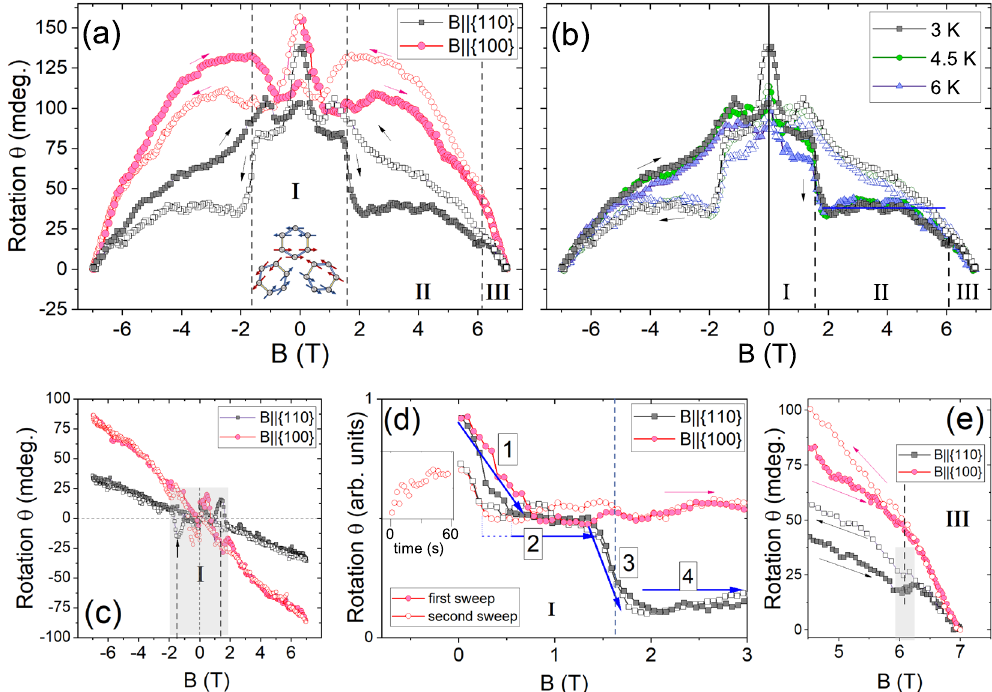
Fig. 3 Magnetic linear dichroism of α -RuCl 3 for different sample orientations. a Full magnetic fi eld sweep scans of the magneto-optical response for B ab ∥ {1, 1, 0} and B ab ∥ {1, 0, 0} at 3 K. The hysteresis loops can be divided into three fi eld regimes I, II, and III, which are discussed in the main text. b Temperature dependence of the MLD response as the magnetic fi eld is aligned along the {1, 1, 0} direction. Labels are discussed in the main text. c Linear MO response extracted from the MLD response for the two different fi eld orientations. The light gray area indicates fi eld-regime I. d Zoom-in into fi eld regime I and II for two subsequent fi eld sweeps, which are divided into four steps as discussed in the main text. Inset shows the zero fi eld time-dependent recovery of MO signal after the fi eld sweep. e High- fi eld regime III. The kink in the rotation for B ab ∥ {1, 1, 0} highlighted by the dashed line is connected to the transition towards the new AFM phase. The shaded area indicates the emergence of the intermediate magnetic